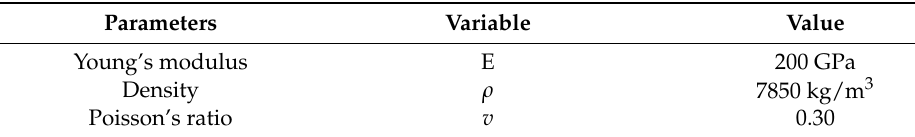
( b ) Figure 11. EMI measurement of SSU embedded in concrete: ( a ) One-fourth symmetry model; ( b ) Conductance response obtained. 6. Numerical Simulations Using Wave Propagation Technique When two or more PZT transducers are considered in the analysis, one of the PZT patches acts as an actuator, i.e., excited by a transient voltage (in the form of sinusoidal tone burst) and the other acting as a receiver utilizing direct piezoelectric effect. PZTs are attached to the surface of a structure or embedded in the concrete structure at a predeter- mined spacing. A schematic diagram of wave propagation (WP) with a PZT transducer is shown in Figure 12. The multiphysics simulation model of WP with embedded SSUs in